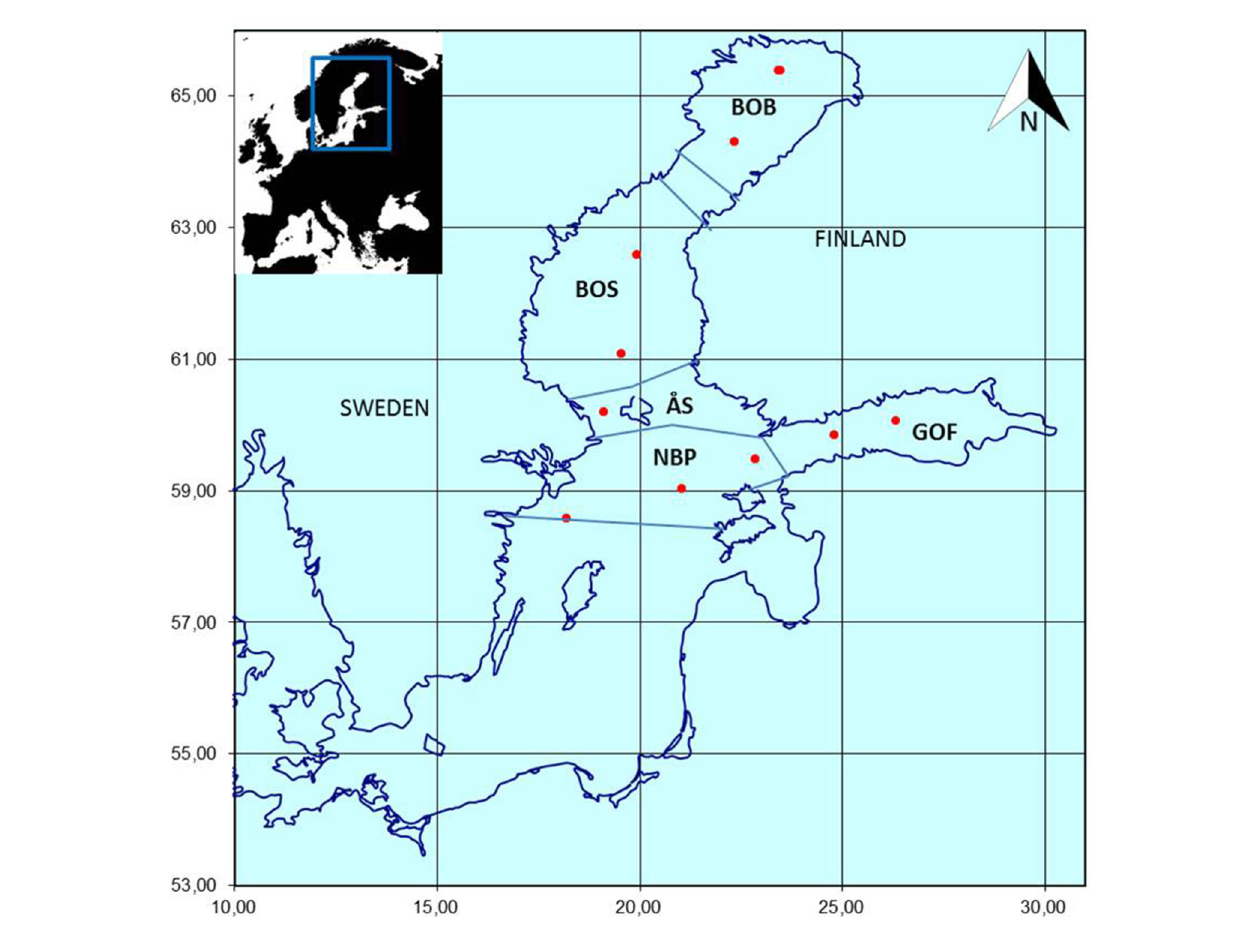
FIGURE 2 | The Finnish HELCOM COMBINE offshore monitoring stations (red dots) in the northern Baltic Sea. Sampling has been performed annually in late summer (from mid-July to mid-September) since 1979. BOB, Bothnian Bay; BOS, Bothnian Sea; GOF, Gulf of Finland; NBP, Northern Baltic Proper; ÅS, Åland